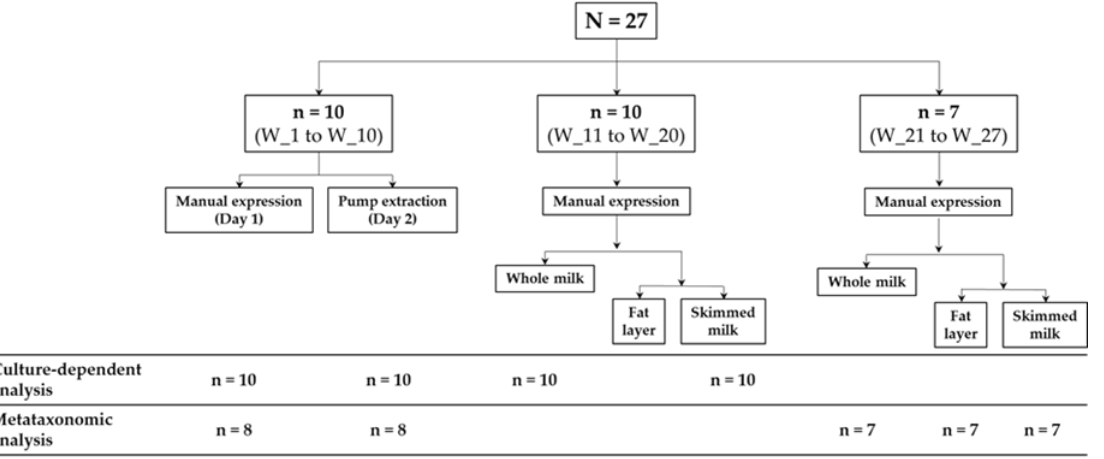
Figure 1. Scheme of the sampling and analysis performed in this study.